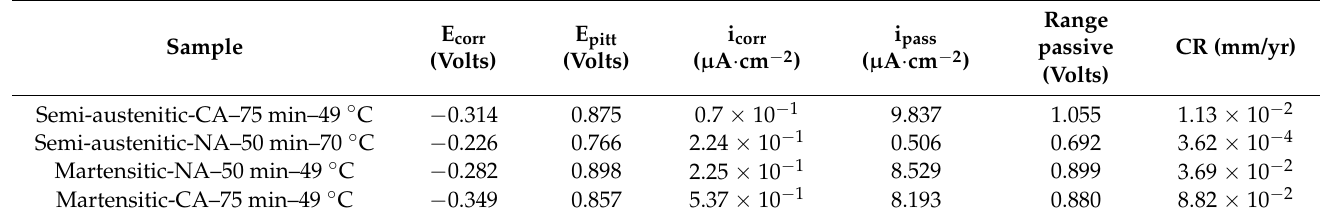
Table 5. Parameters obtained by PP for passivated martensitic and semi-austenitic. PHSS in 1 wt.% H 2 SO 4